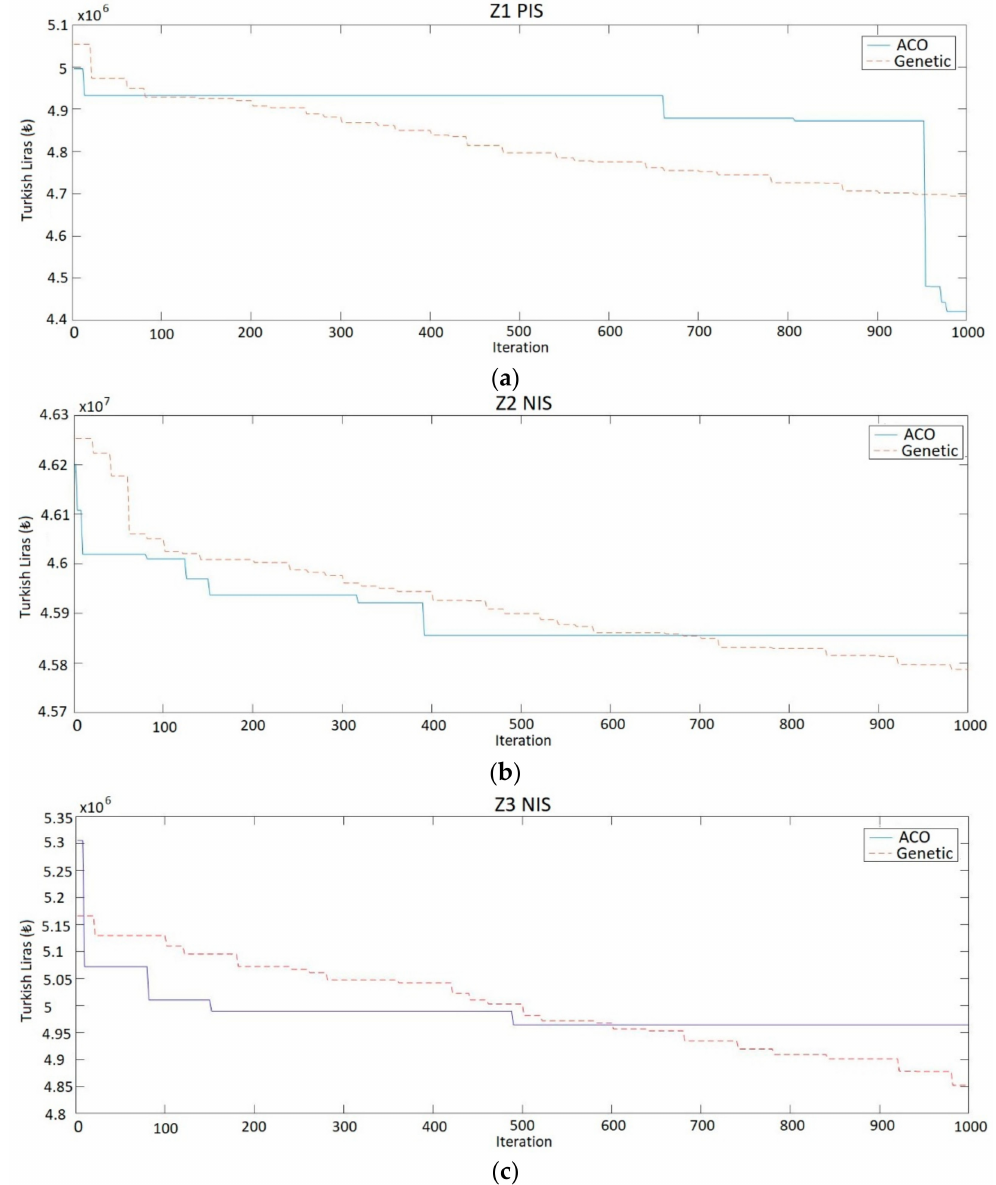
Figure 4. ( a ) Minimization process of the Z 1; ( b ) minimization process of the Z 2; and ( c ) minimization process of the Z